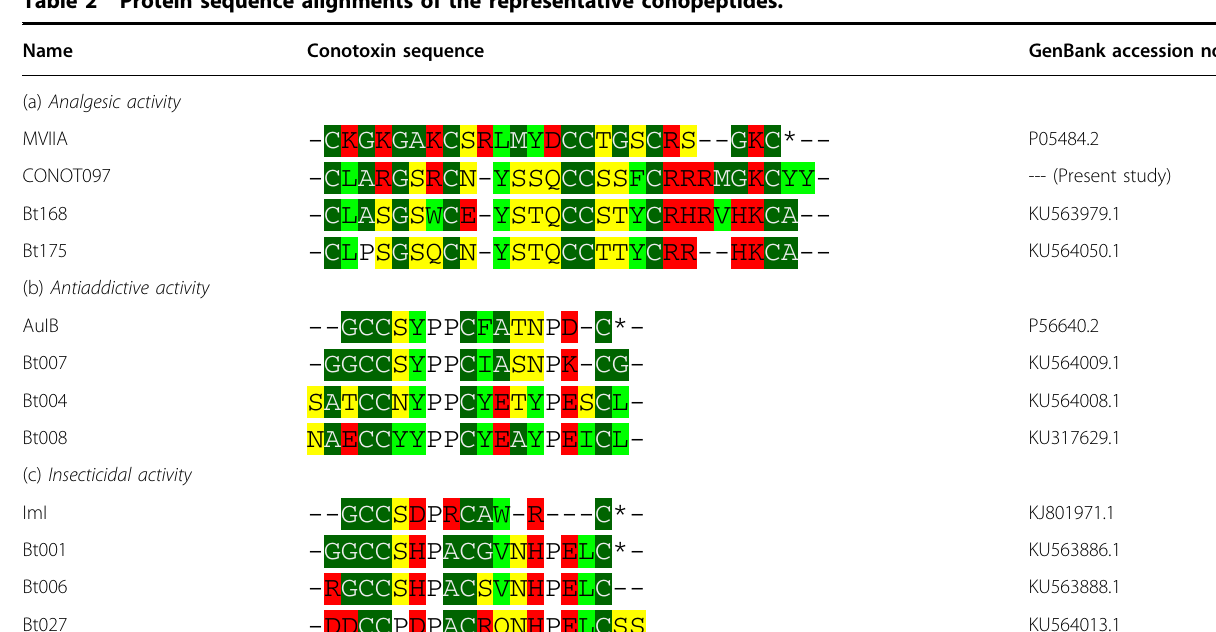
Table 2 Protein sequence alignments of the representative